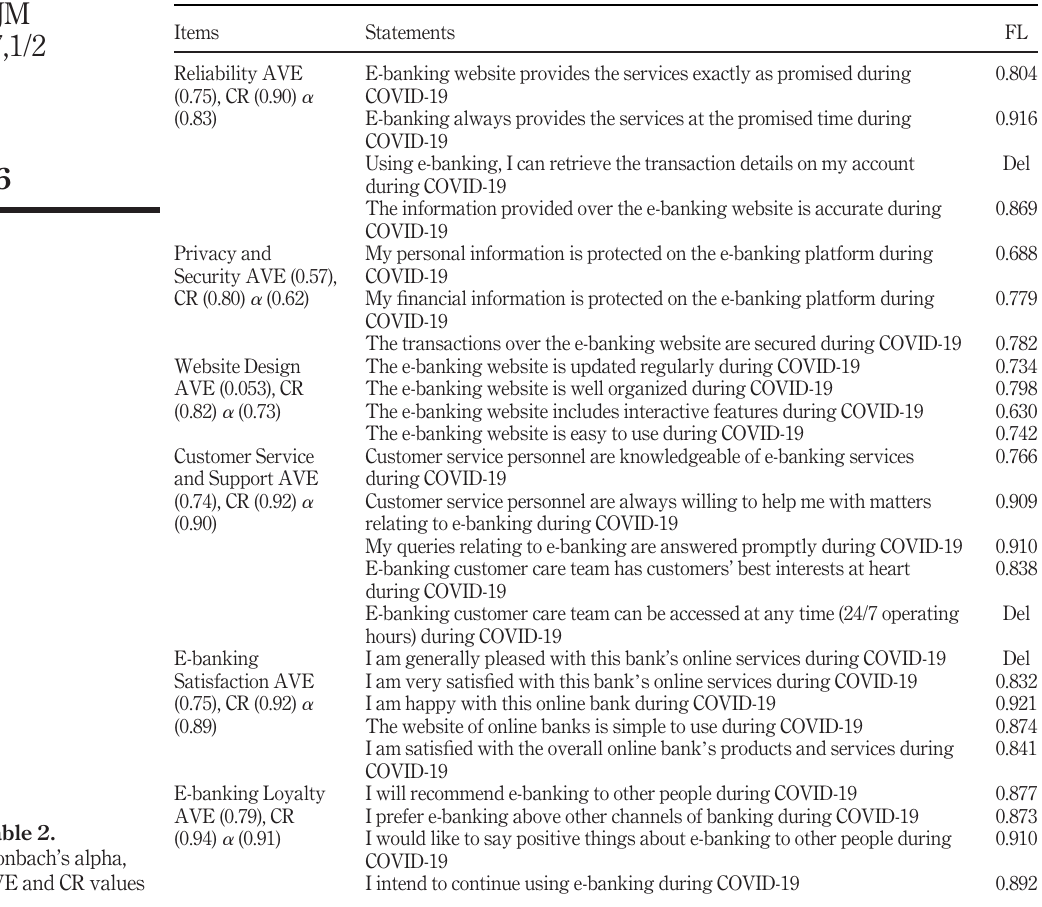
Table 2. Cronbach ’ s alpha, AVE and CR